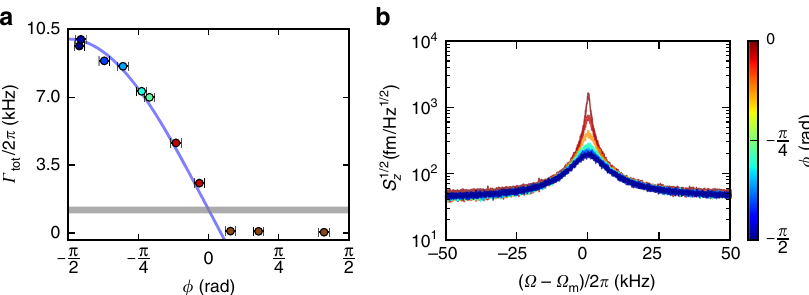
Fig. 3 Magnetic feedback cooling and self-oscillations. a The total dissipation, Γ tot /2 π , as a function of phase in the feedback loop, shows excellent agreement with a fi t to Eq. (4) (blue curve). The optical power is 4.1 μ W at the device. Error bars represent the standard deviation in the phase noise 37 , as measured by the Zurich lock-in ampli fi er. Maximum damping occurs at − π /2, and self-oscillation 25 occurs for measured phases greater than zero (brown). The grey horizontal line shows the intrinsic dissipation, Γ i /2 π = 930 Hz, identical to the total dissipation at ϕ = 0. b The same colour-coded data represented in terms of calibrated displacement spectral densities, for ϕ < 0